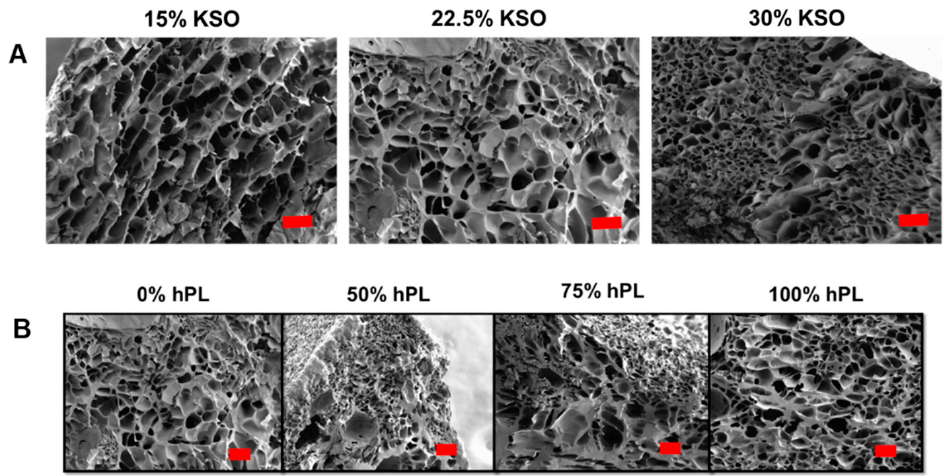
Figure 1. SEM images of human platelet lysate (hPL)-loaded keratin (KSO) hydrogels. KSO hydrogels with no hPL-loading ( A ) showed decrease in porosity with increasing KSO weight percentage. hPL-loaded 22.5% KTN hydrogels ( B ) showed no observable changes in porosity with increase in hPL-loading concentration. Scale bar = 100 μ m.